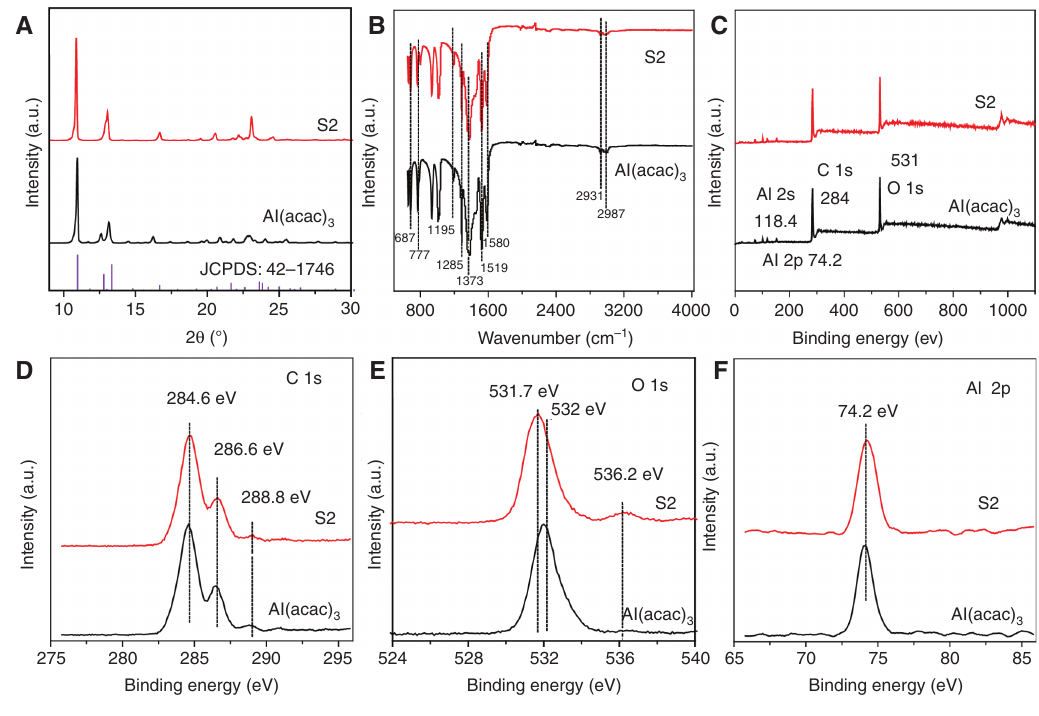
Figure 3: Structral characterization of S2. (A) XRD patterns, (B) FTIR spectra, and (C) XPS survey spectra of S2 and Al(acac) C 1s, (E) O 1s, and (F) Al